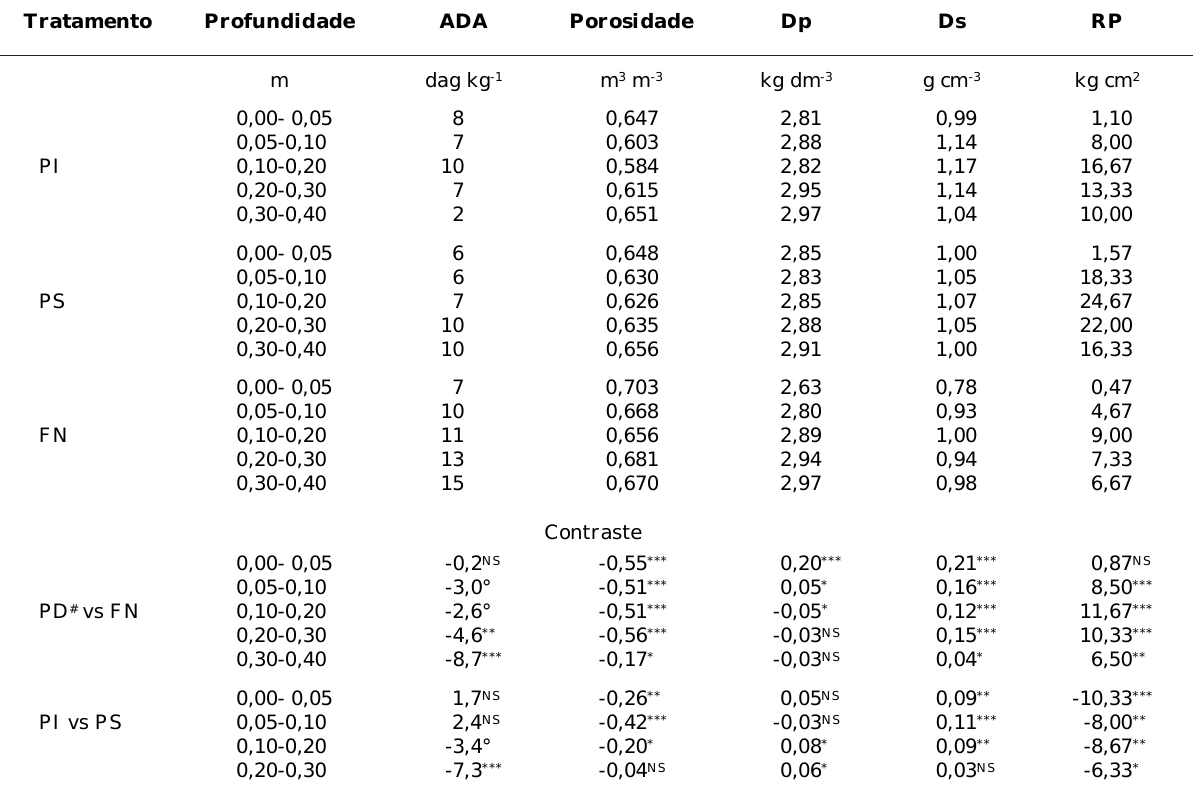
Quadro 4. Argila dispersa em água (ADA), densidade de partícula (Dp), porosidade, resistência ao penetrômetro (RP) e densidade do solo (Ds) de um Latossolo Vermelho Eutroférrico Típico sob plantio direto irrigado (PI), plantio direto de sequeiro (PS) e floresta nativa (FN), em cinco profundidades, e valores de contrastes para as mesmas